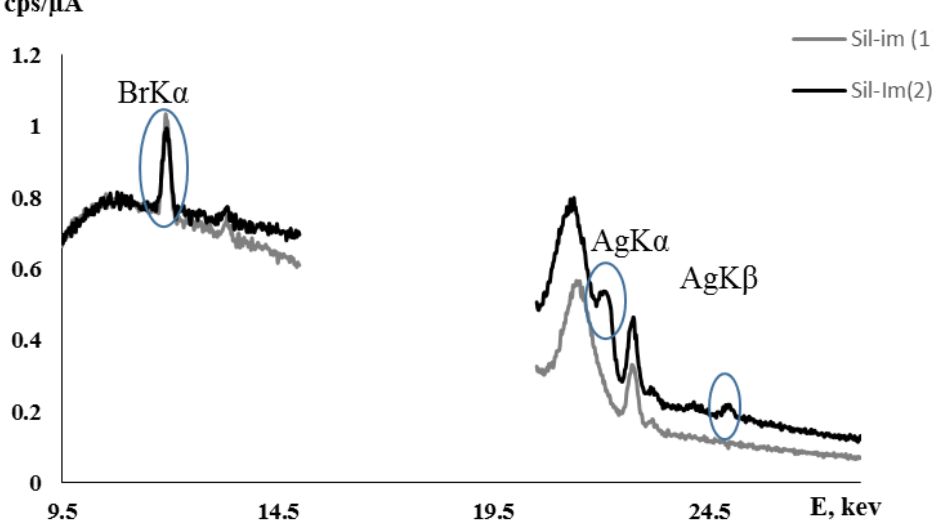
Figure 6. X-ray fluorescence spectrum Sil-Im (1) and Sil-Im (2) — pre-equilibrated with a solution of Ag(I) in 0.1 M HNO 3